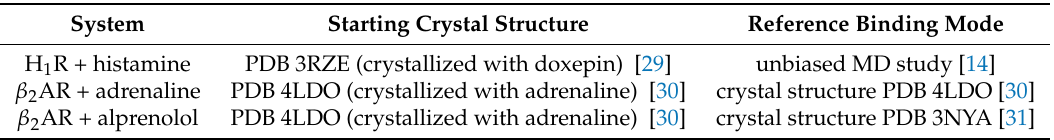
Table 1. Overview of the systems investigated including the starting structures and the reference binding modes used for the validation of the suggested protocol. Note that all starting structures were equilibrated for more than 2 µ s without a ligand after membrane insertion (for details see